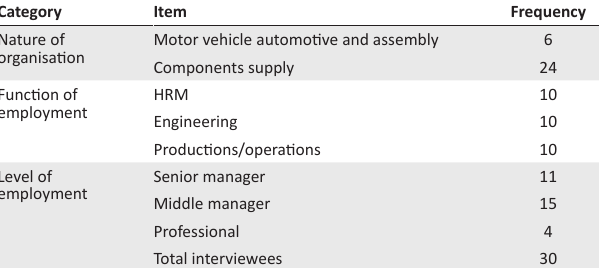
TABLE 1: Biographical information of participants. Category